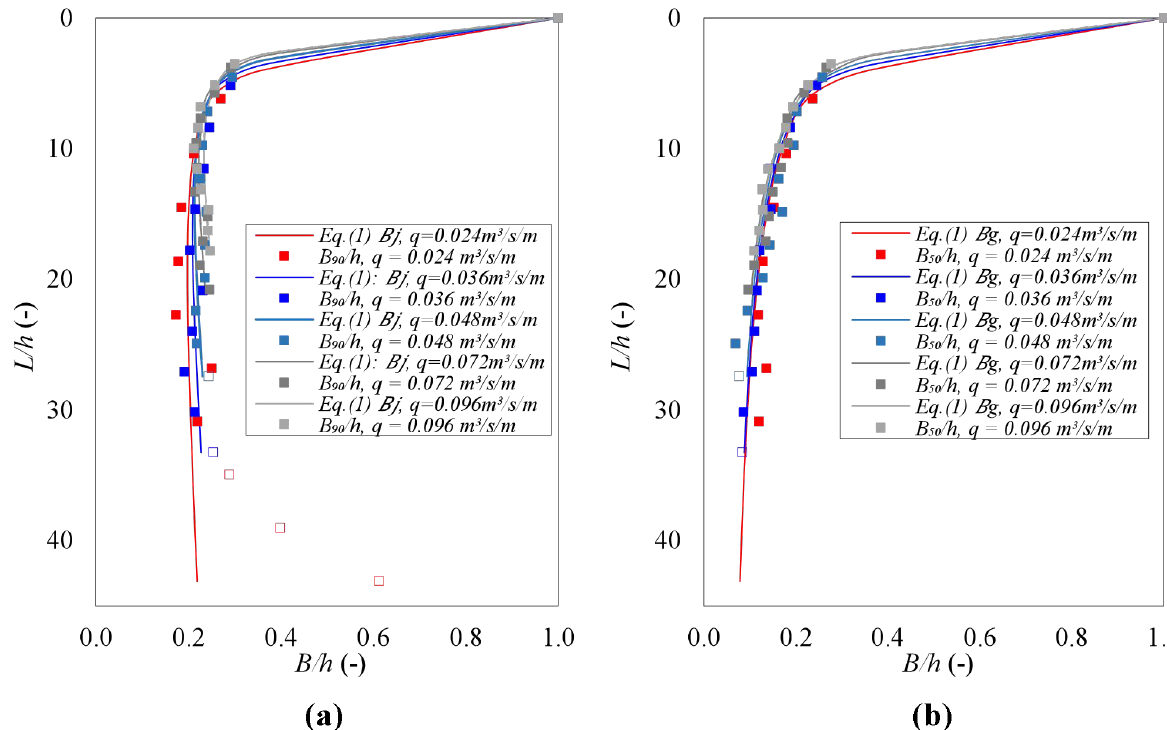
Figure 7. Evolution of the dimensionless jet thickness during the fall (filled marker: case L ≤ L b ; unfilled marker: case L > L b ): ( a ) B 90 /h and B j /h ; ( b ) B 50 /h and B g /h